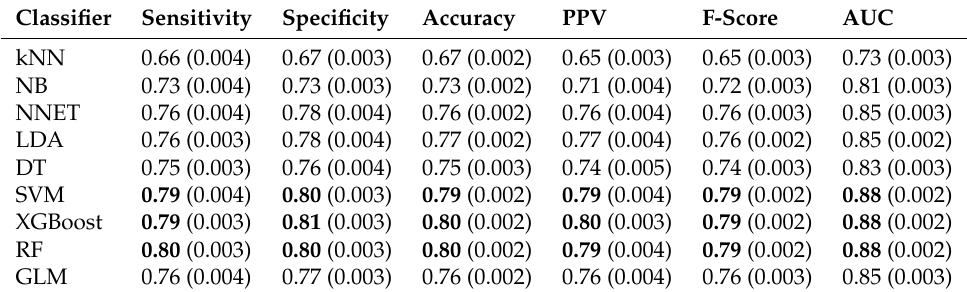
Table 6. Predictive performance of machine learning and generalised linear models based on the estimated sensitivity, specificity, accuracy, positive predictive value (PPV), F-score and the area under receiver operating characteristic curve (AUC) using cross validation studies for combined